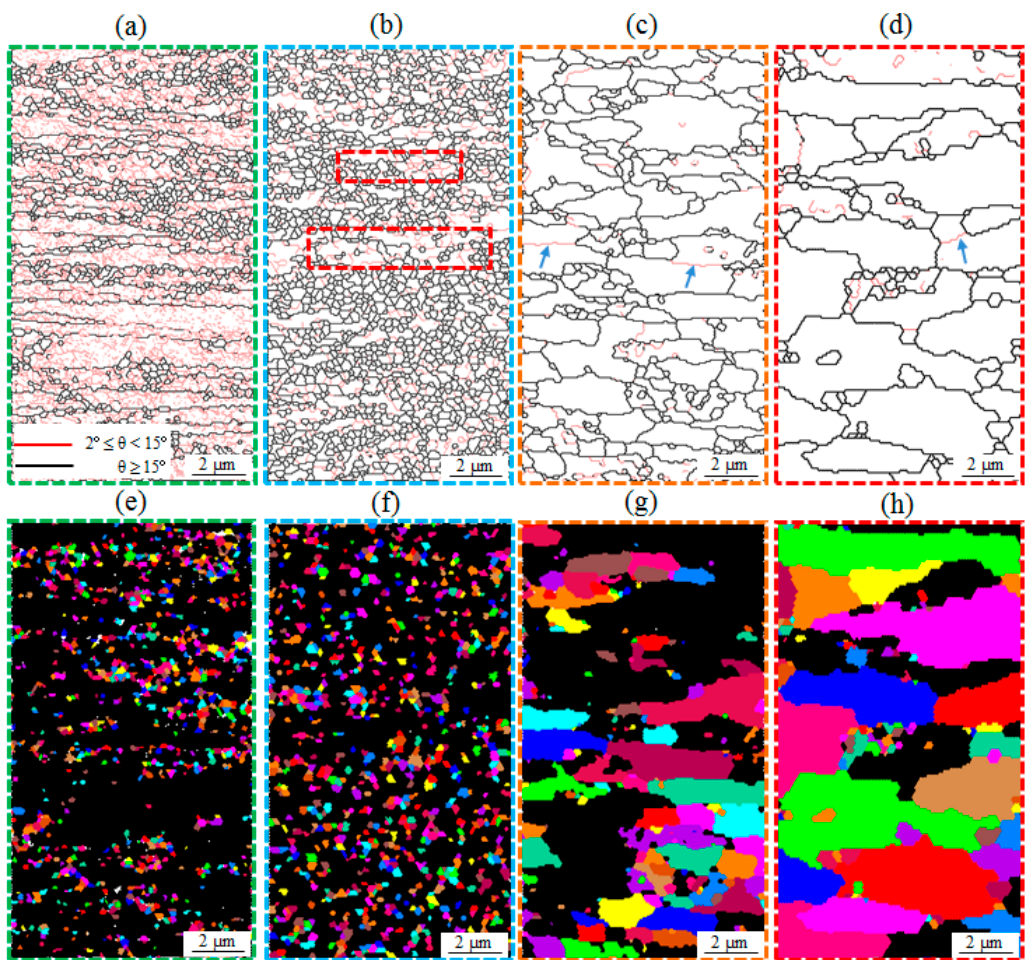
Figure 6. Grain boundaries maps and recrystallized microstructures of the DSR-deformed 6061 Al alloy annealed for 1 h at ( a , e ) 225 °C ( b , f ) 275 °C ( c , g ) 325 °C ( d , h ) 350 °C.